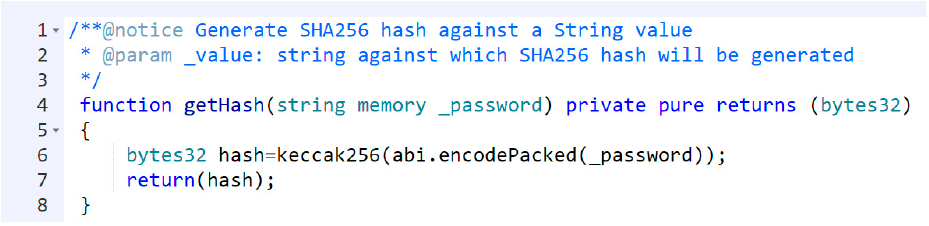
Figure 15. Code snippet of Hashing.